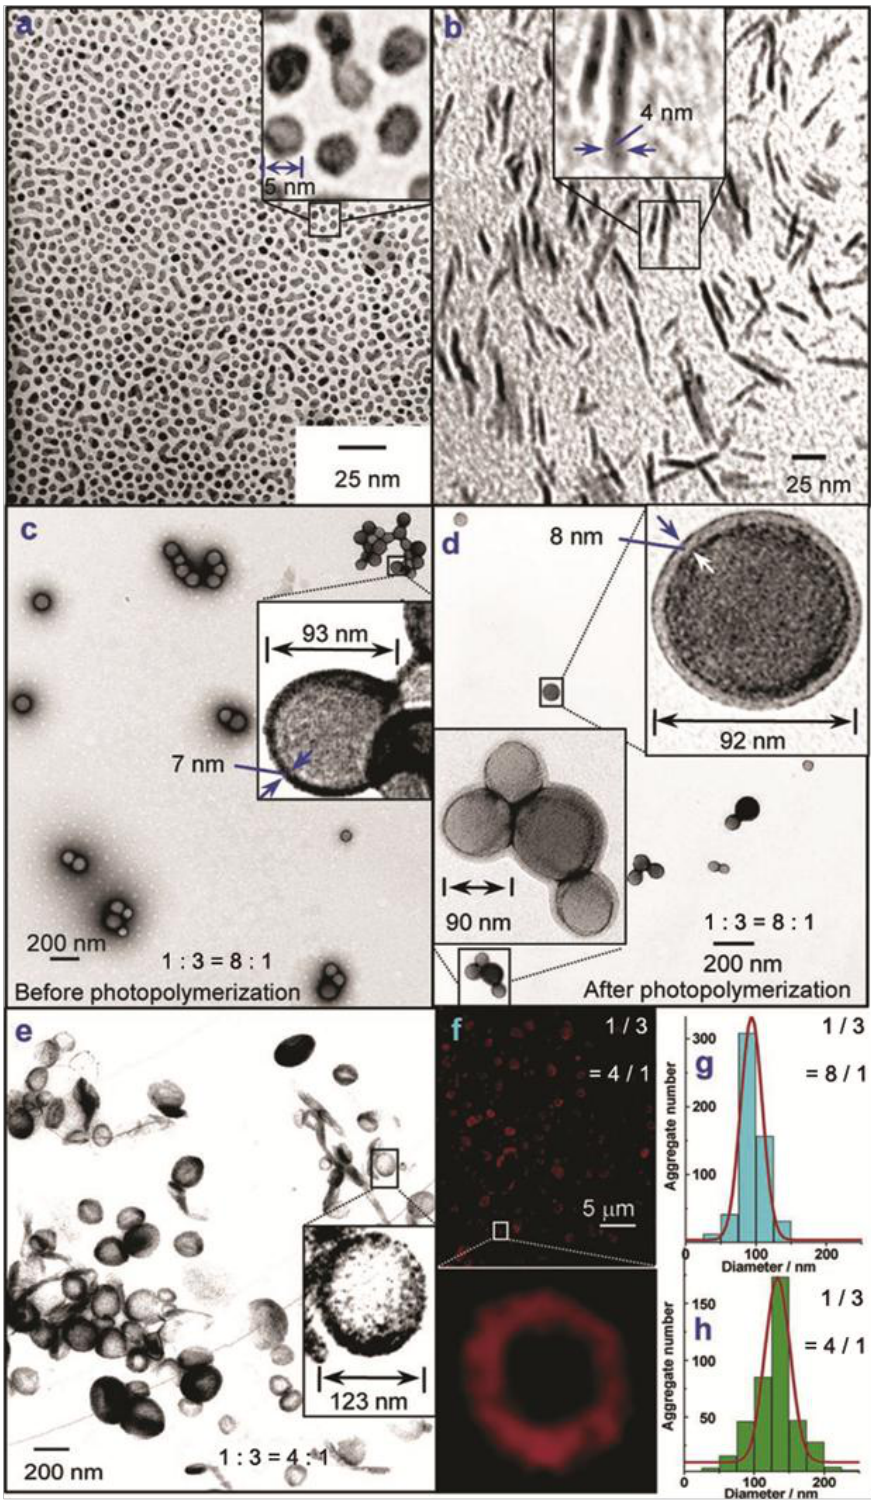
Figure 2. TEM images of self-assembled PBI 1 ( a ), PBI 4 ( b ), ( c – d ) co-aggregates of PBI 1 and PBI 3 in a 8:1 molar ratio; TEM ( e ) and confocal fluorescence images ( f ) of co-aggregates of PBI 1 and PBI 3 in a 4:1 molar ratio in THF-containing water (2%, v / v ). Aggregate size distribution of the vesicular co-aggregates ([PBI 1 ]/[PBI 3 ] = 8/1) ( g ) and ([PBI 1 ]/[PBI 3 ] = 4/1) ( h ). [PBI 1 ] = 0.5 mg mL −1 (4.32 × 10 −4 M); [PBI 4 ] = 0.5 mg mL −1 . Reprinted with permission from [15]. Copyright 2007 American Chemical